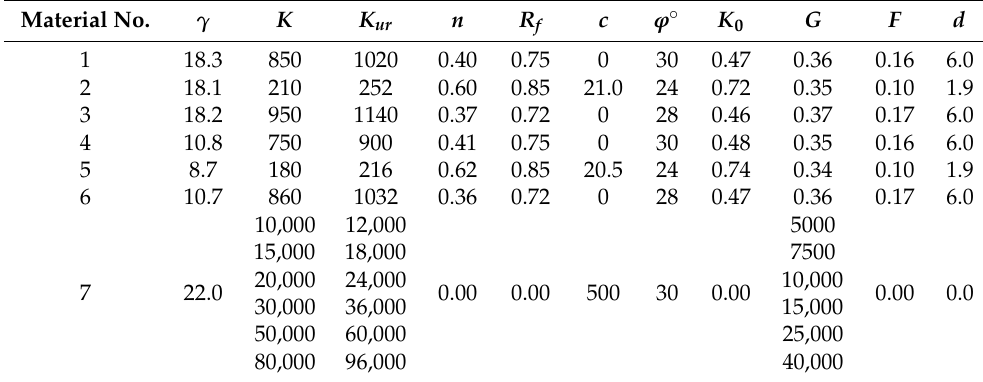
Table 5. The material parameter table of main dam. Material No.